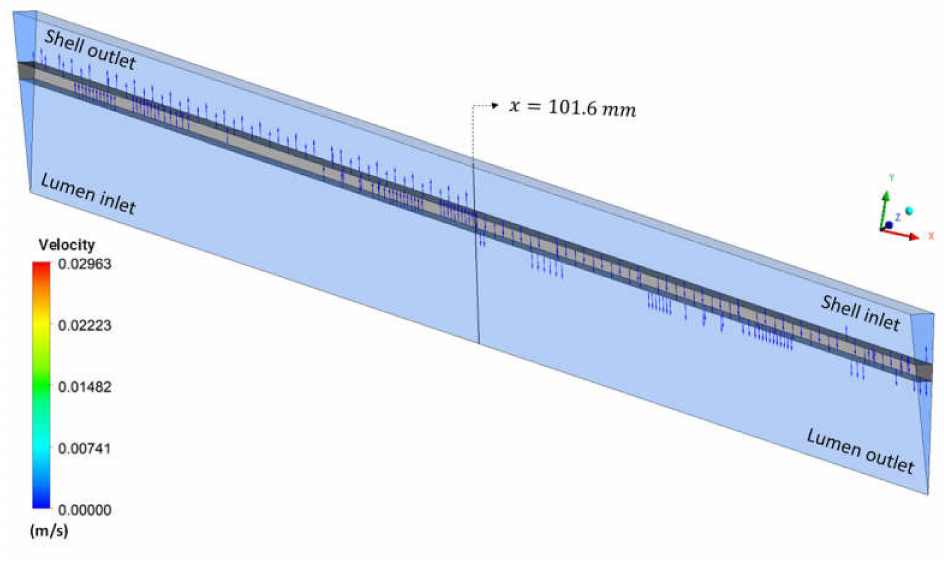
Figure 19. Urea velocity vectors at the hollow fiber membrane interface at t = 6200